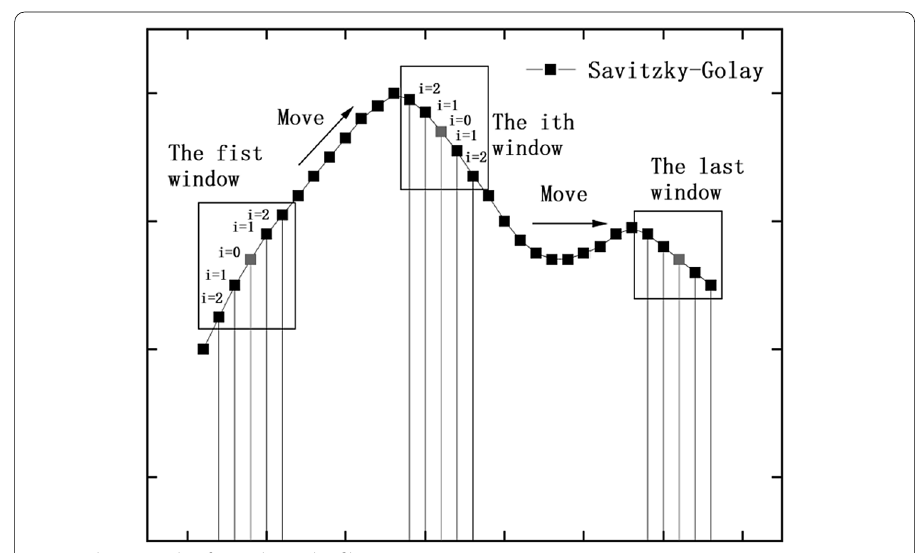
Fig. 3 The principle of Savitzky–Golay